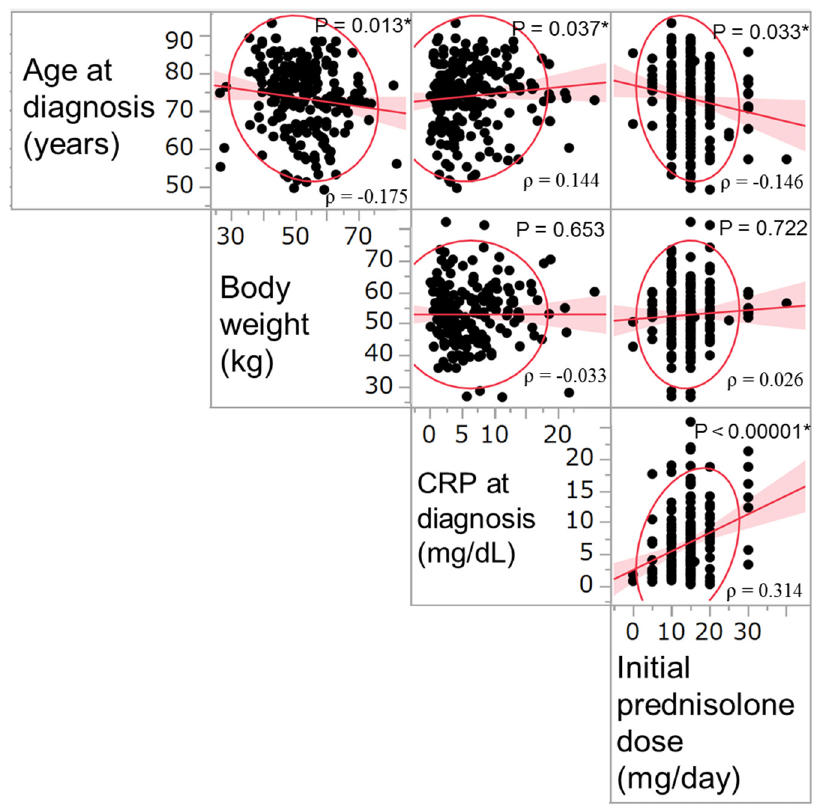
Figure 1. Correlations between the variables of age, body weight, CRP levels, and prednisolone dose at diagnosis ( N = 224). Asterisks show statistical significance ( p < 0.05). CRP, C-reactive